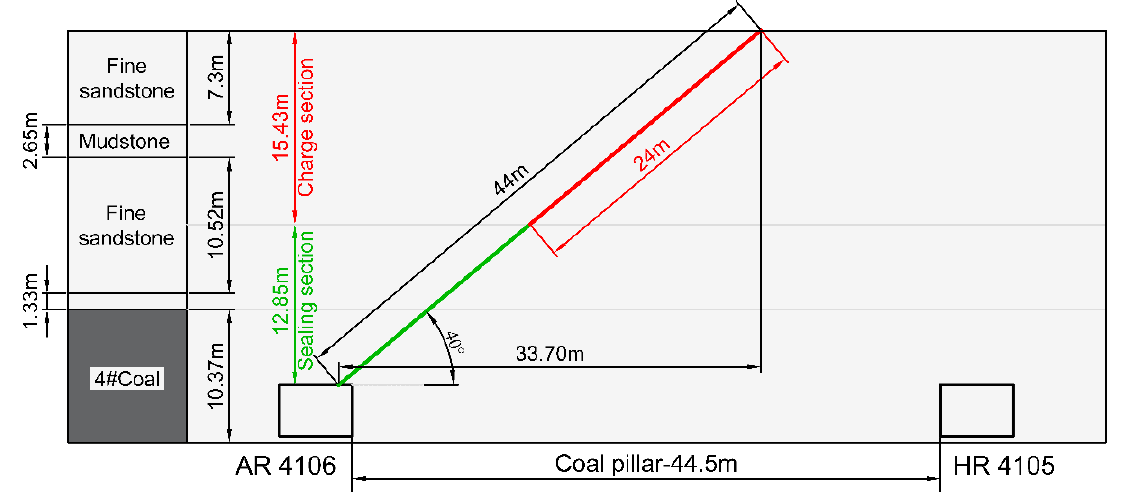
Figure 8. Schematic diagram of borehole location of deep-hole pre-splitting blasting.